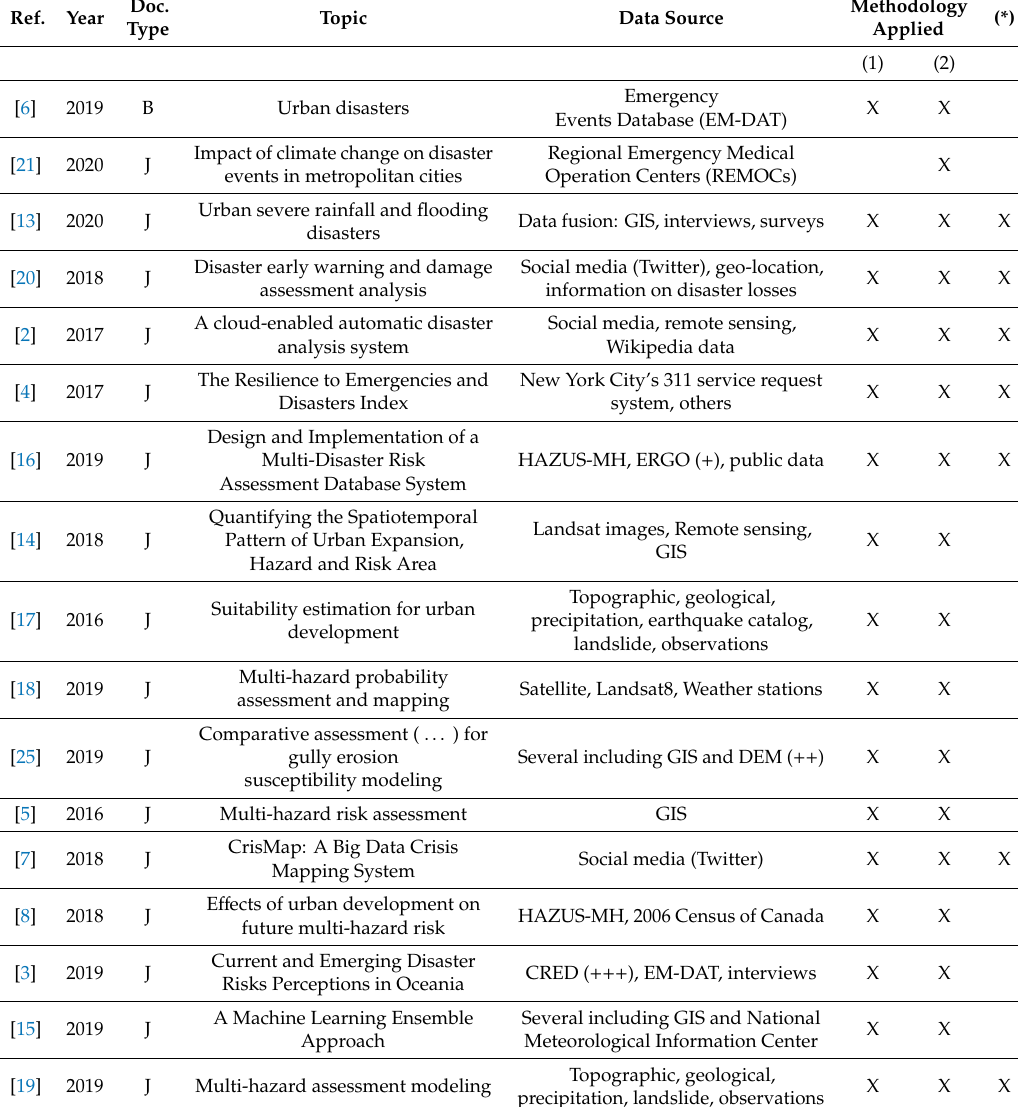
Table 1. Summary of the publications found in the literature search. (*) Decision